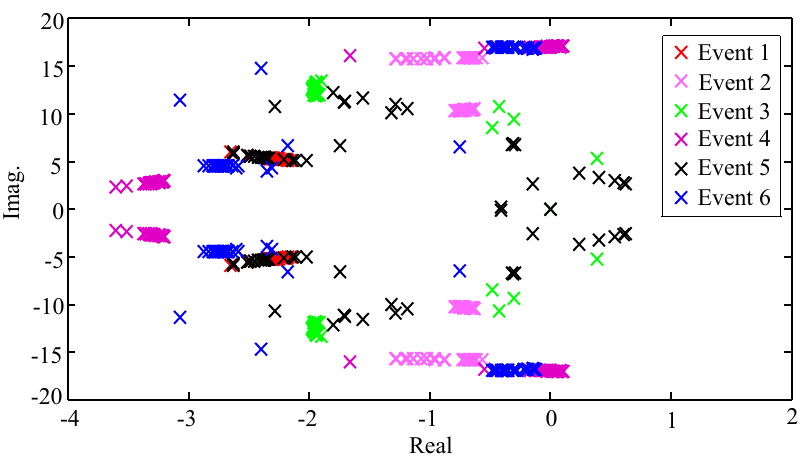
Figure 5. Modes deviations of reduced polytopic LPV models during TDS.